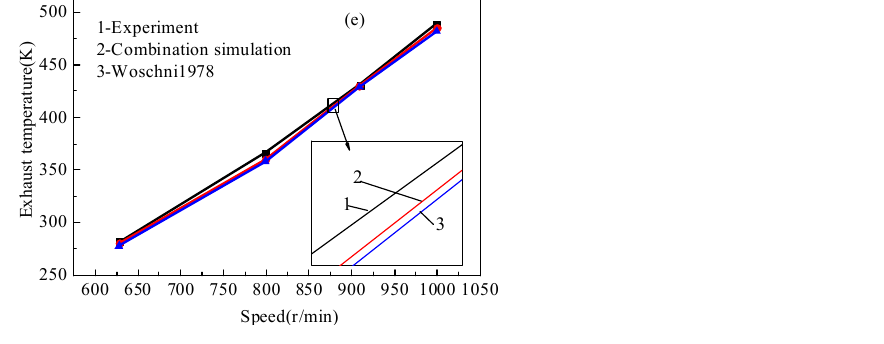
Figure 5. Propulsion characteristic of an electronically-controlled diesel engine. ( a ) Torque; ( b ) BSFC; ( c ) Temperature of behind the inter-cooler; ( d ) NO x ; ( e ) Exhaust temperature